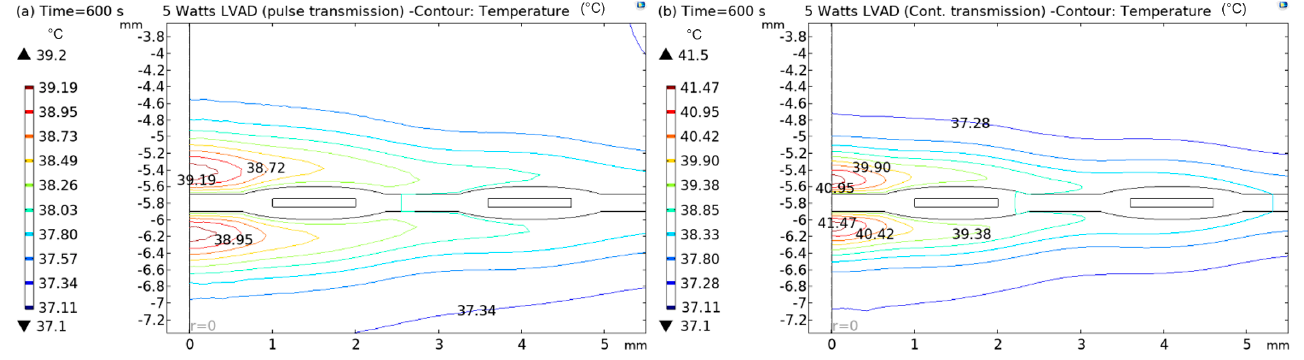
18 of 22 Figure 13. Contour plots of thermal analysis: ( a ) pulsed and ( b ) continuous transmission modes for 2.5 W LVAD. In Figures 12–15, both (a) and (b) show the contour plots of the thermal analysis ob- tained from the in silico analysis in pulsed transmission modes for 2.5 W, 5 W, and 8 W LVADs power levels. In Figure 12a,b, it can be seen that the temperature varies from 37.1 °C to 38.38 °C in pulsed mode and from 37.1 °C to 39.01 °C in continuous transmission mode for 2.5 W LVAD. For 2.5 W LVAD, both transmission modes have a very low ther- mal profile. Perhaps, blood perfusion reduces the heat generated due to power transmis-